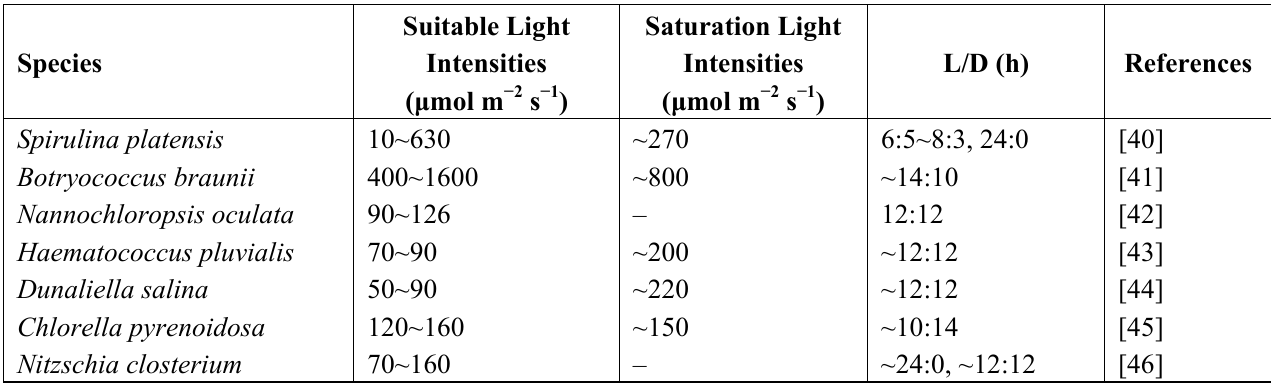
Table 5. Summary of light conditions for typical